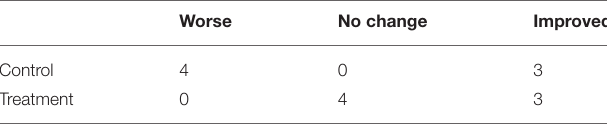
TABLE 1 | Summary of CKD stage progression and corresponding number of cats at pilot study end. Worse No change